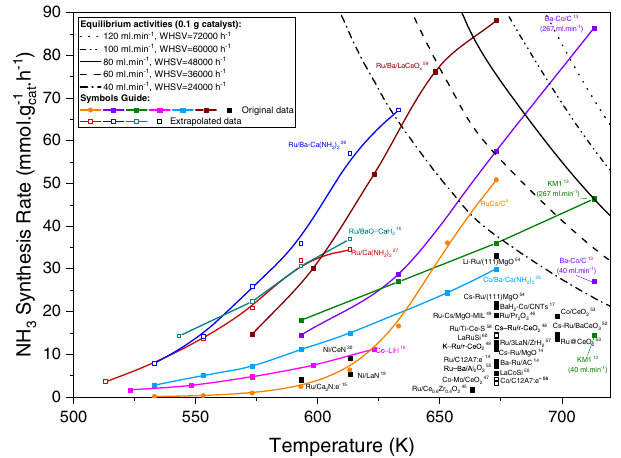
Fig. 1 Experimental activities for ammonia synthesis. Overview of some of the most recent and promising catalysts reported for ammonia synthesis 13 – 20,26,27,45 – 60 . Most of the data points ( fi lled symbols) are extracted from original references based on the following conditions: pressure = 10 bar, H 2 /N 2 = 3. The open symbols are estimated values (at 10 bar) based on the original data reported at slightly lower pressures (9 bar). The curves in the upper right corner show the equilibrium activity over 0.1 g of catalyst in different overall fl owrates (all H 2 /N 2 = 3). Data from the is included as a benchmark. The references for these catalysts are marked with superscripts. Superscript “ a ” indicates the prepared RuCs/C catalyst in this